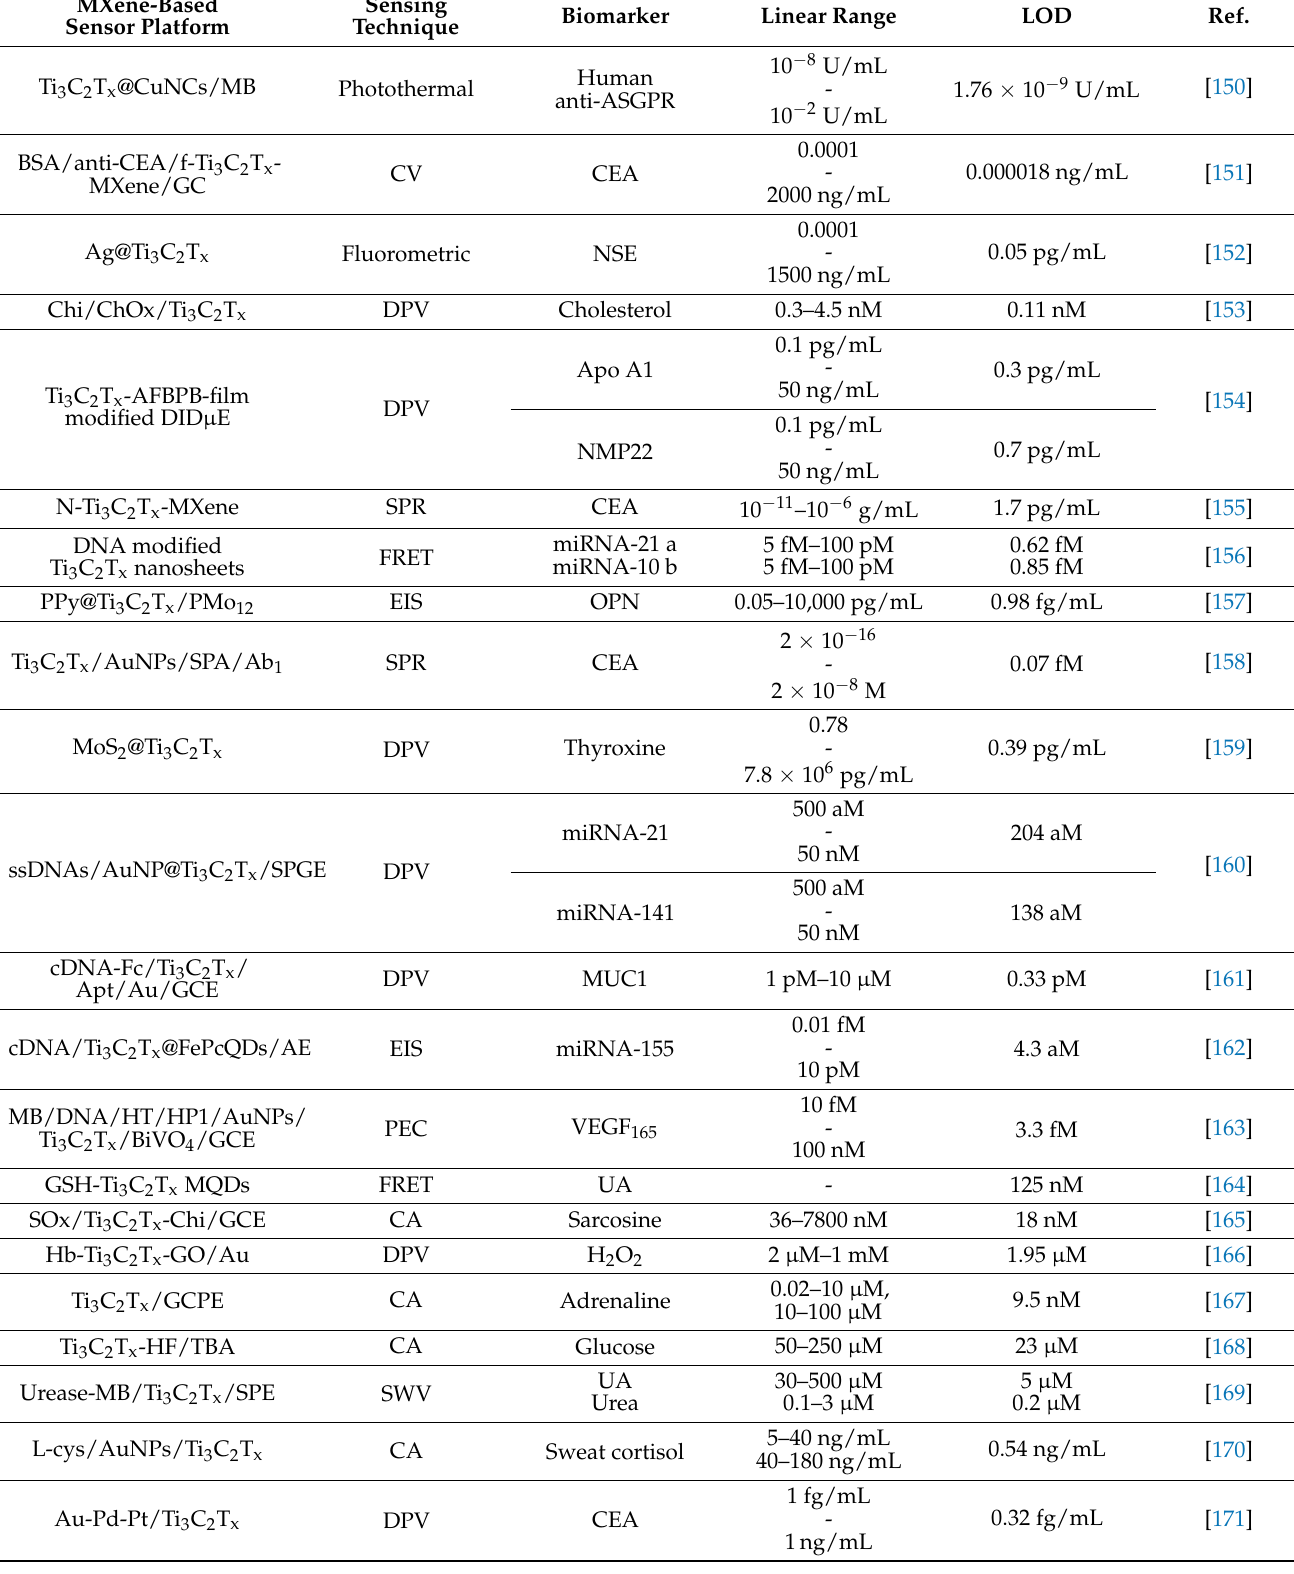
Table 5. Literature reports on MXene-based biomarker detection